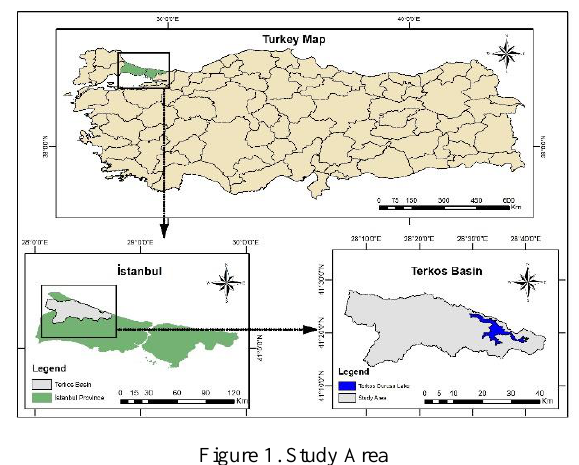
Figure 1. Study Area